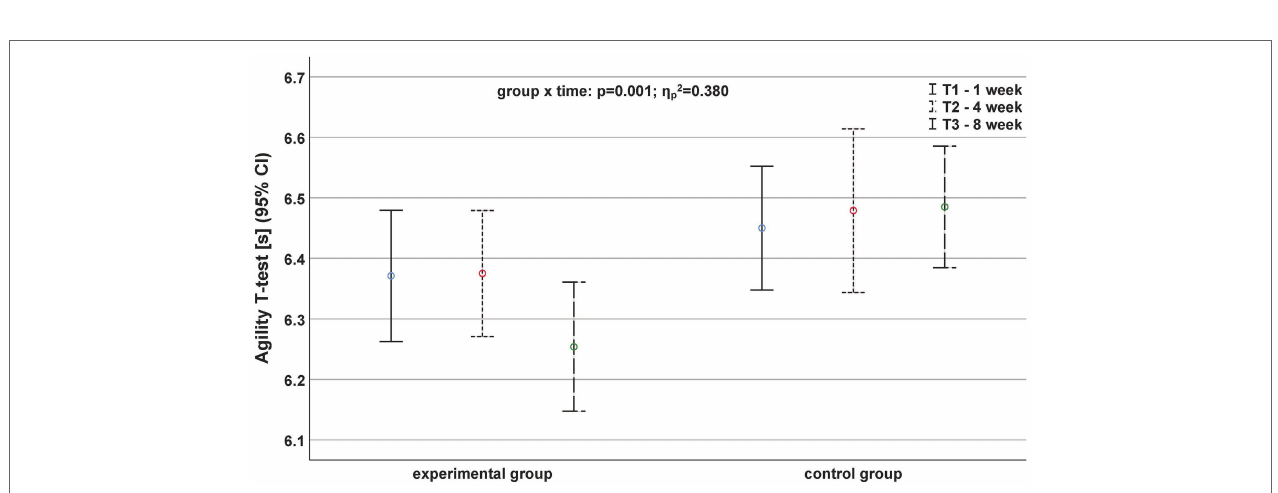
FIGURE 2 | Development of sprinting performance based on the parameter sprint 30 m before (continuous black line), after 4 weeks (fine dashed black line), and after (roughly dashed black line) the exercise program depending on the group.